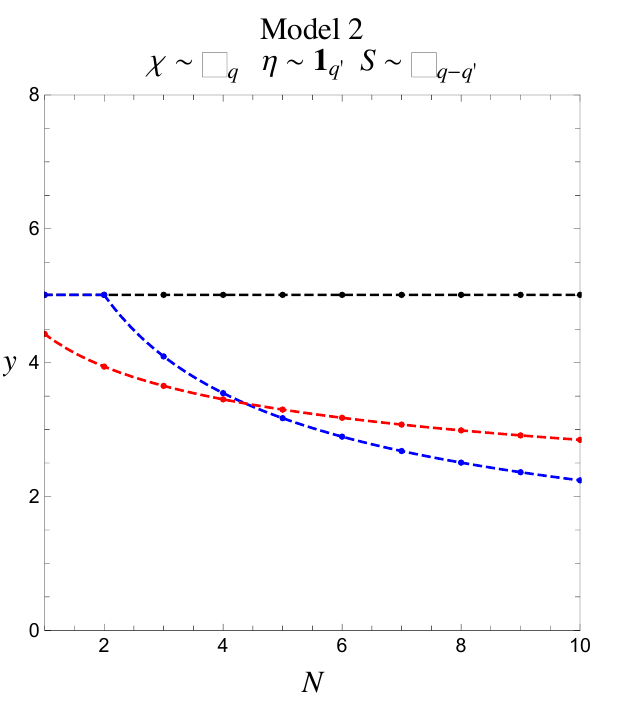
Figure 2 . PU bounds on the Yukawa couplings y for the model 2 of the Dirac type class for J = 0 (black), J = 1 / 2 (blue) and J = 1 (red). In this case the scalar is always a complex